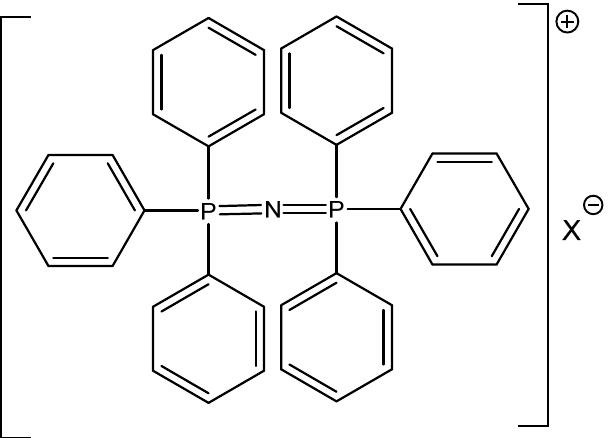
Figure 9. Structure of bis(triphenylphosphoranylidene)ammonium halide (PPNX) [73]. Table 17. Cycloaddition of CO 2 to glycidol producing hydroxymethyl ethylene carbonate (HMEC) [74].